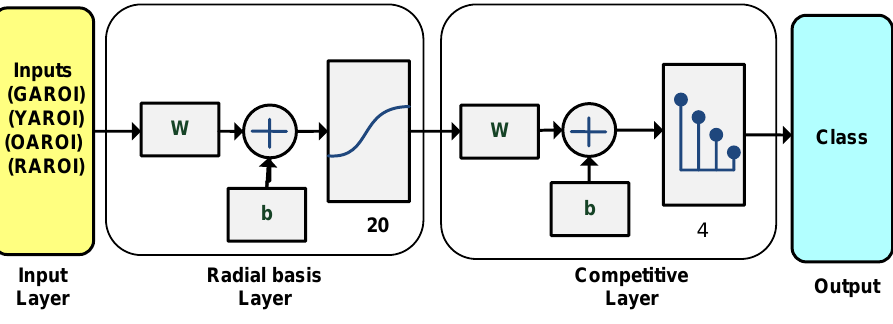
Figure 8. RBF-ANN maturity classifier.